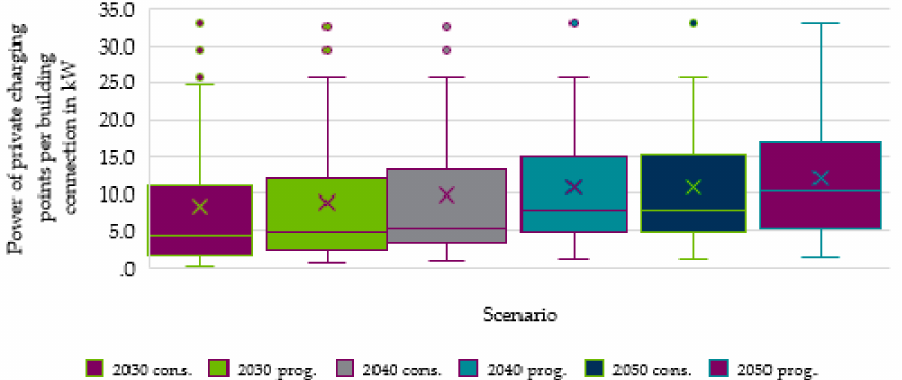
Figure 21. Average effective charging capacity of private charging points per building connection from the perspective of feeders (not including feeders without private charging infrastructure) for 20 low-voltage grids based on